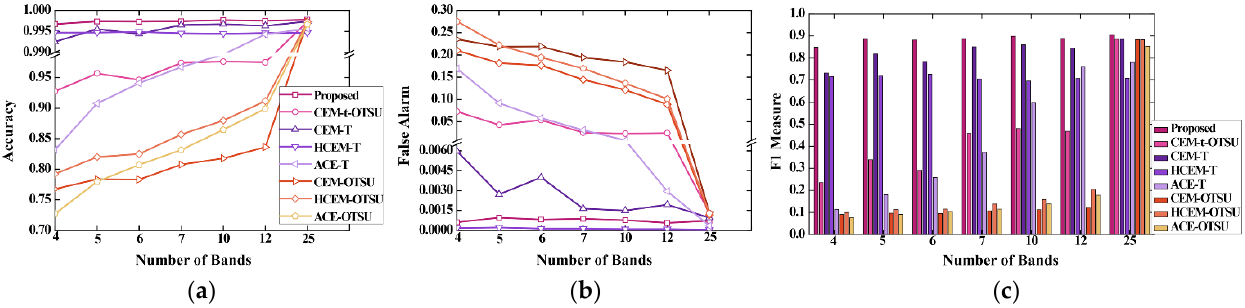
Figure 8. The quantitative comparison of ASRC-net detection results in the Lawn scene. ( a ) The curves of C A obtained using different methods; ( b ) The curves of F a obtained using different methods. ( c ) The histograms of F 1 obtained using different methods.